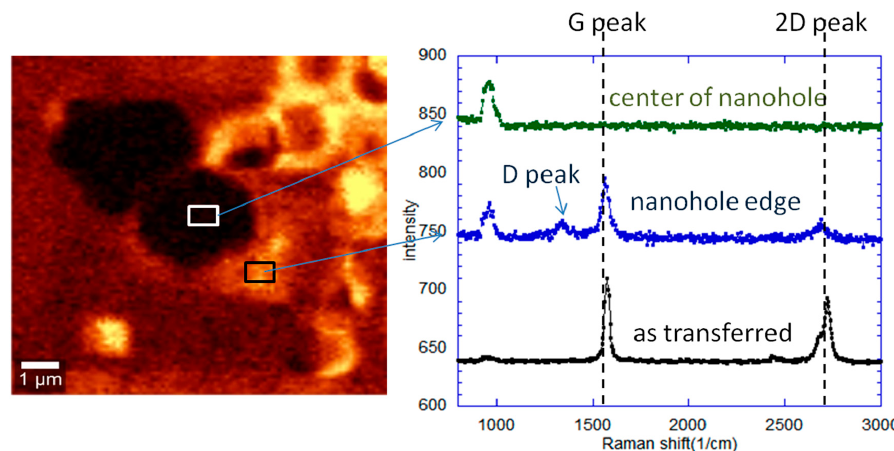
Figure 7. Changes in Raman spectra of graphene at the center of the nanohole and graphene edge.